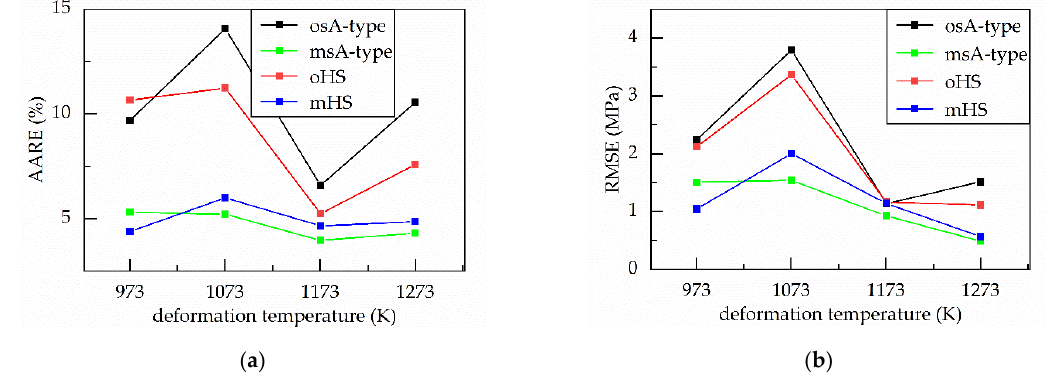
Figure 23. ( a ) average absolute relative error (AARE); ( b ) root mean square error (RMSE) obtained based on the experimental and predicted stress from the four constitutive equations under the different deformation temperatures.